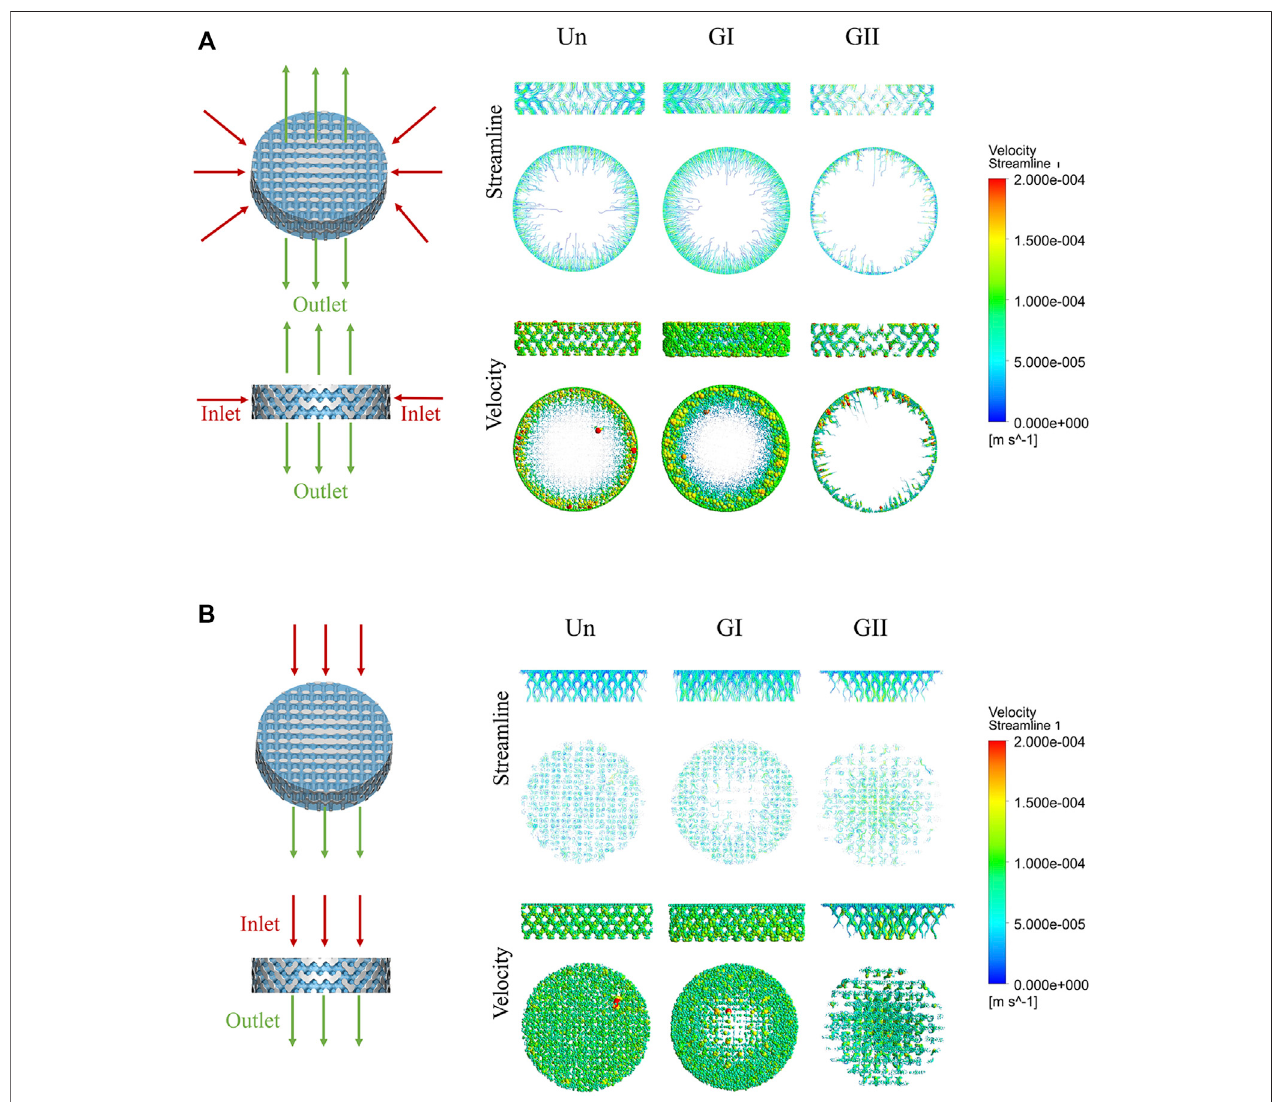
FIGURE4 | CFD simulation analysisof porous scaffolds with different structures. (A) Horizonal direction ofCFD simulation, the inlet was from outside toinside, the outlet was from center to top and bottom. (B) Vertical direction of CFD simulation, the direction from inlet to outlet was from top to bottom. Streamline and velocity fi eld distribution and variation from the inlet to the outlet.